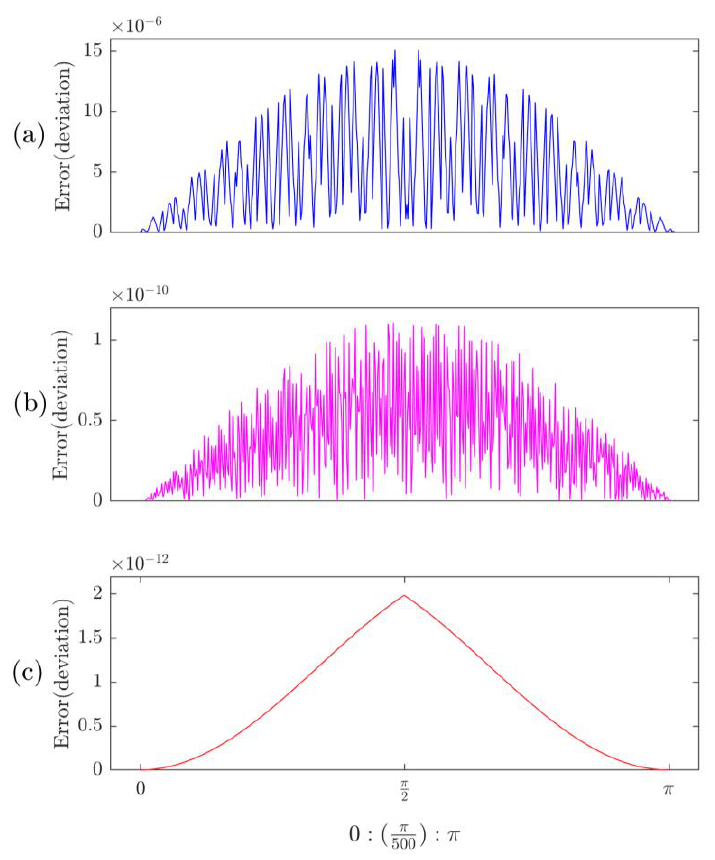
Figure 3. 16-bit accuracy comparison among different methods: ( a ) Radix-2, ( b ) Radix-4, ( c ) RT.